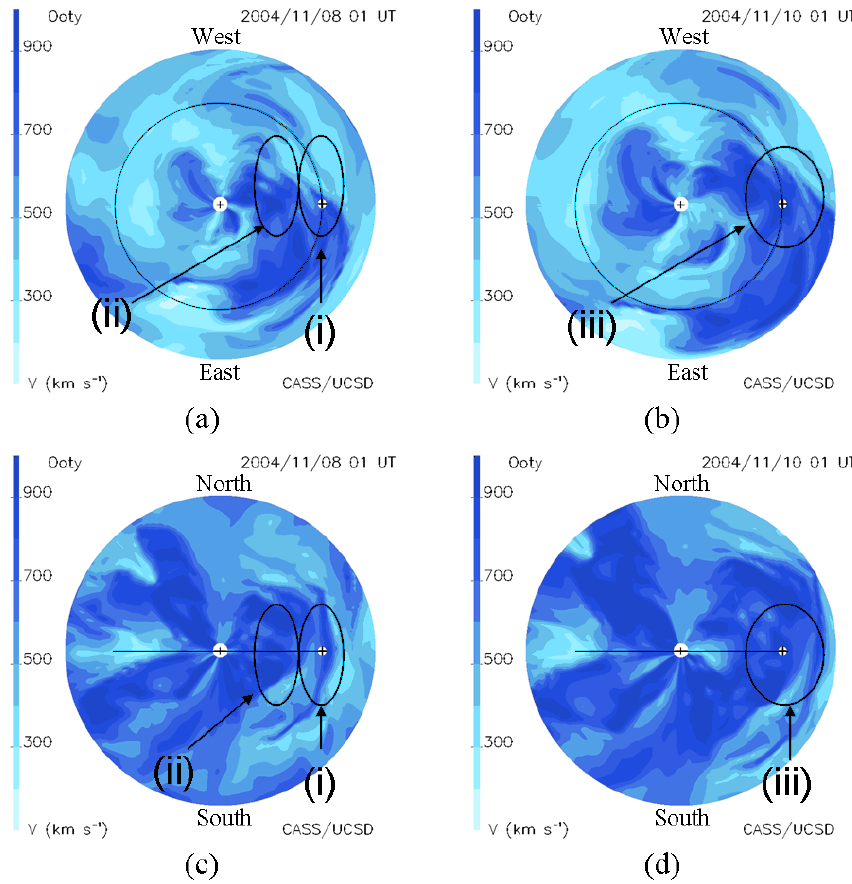
Fig. 3. Summary figure of the Ooty ecliptic-, (a) and (b) , and meridional-, (c) and (d) , cuts through the 3-D velocity reconstruction out to 1.5AU at the times shown. Various features are circled in the images which are also related to features seen in Fig. 2 as per the text. Material following the circled region (iii) is likely the bottom-right LASCO C2 event in Fig. 1 and not related to the two geomagnetic storms. Earth’s orbit is shown as a near-circle or line with the Earth, ⊕ , indicated on each plot. Velocity contours are shown to the left of each of the four